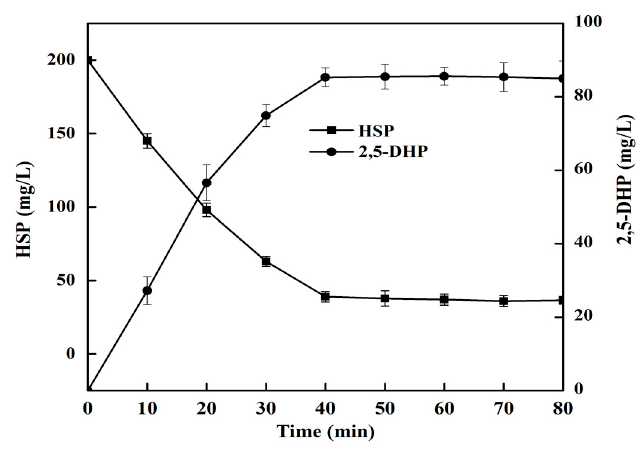
Figure 5. Time course of 2,5 ‐ DHP (circles) production from HSP (boxes) under the optimum condition. The reactions were performed in 20 mM Tris ‐ HCl buffer (pH 8.5) containing 10 mM FAD, 1.0 μ M enzyme, 200 mg/L HSP, and 0.5 mM NADH at 30 °C for 80 min. The values are means of three independent experiments.